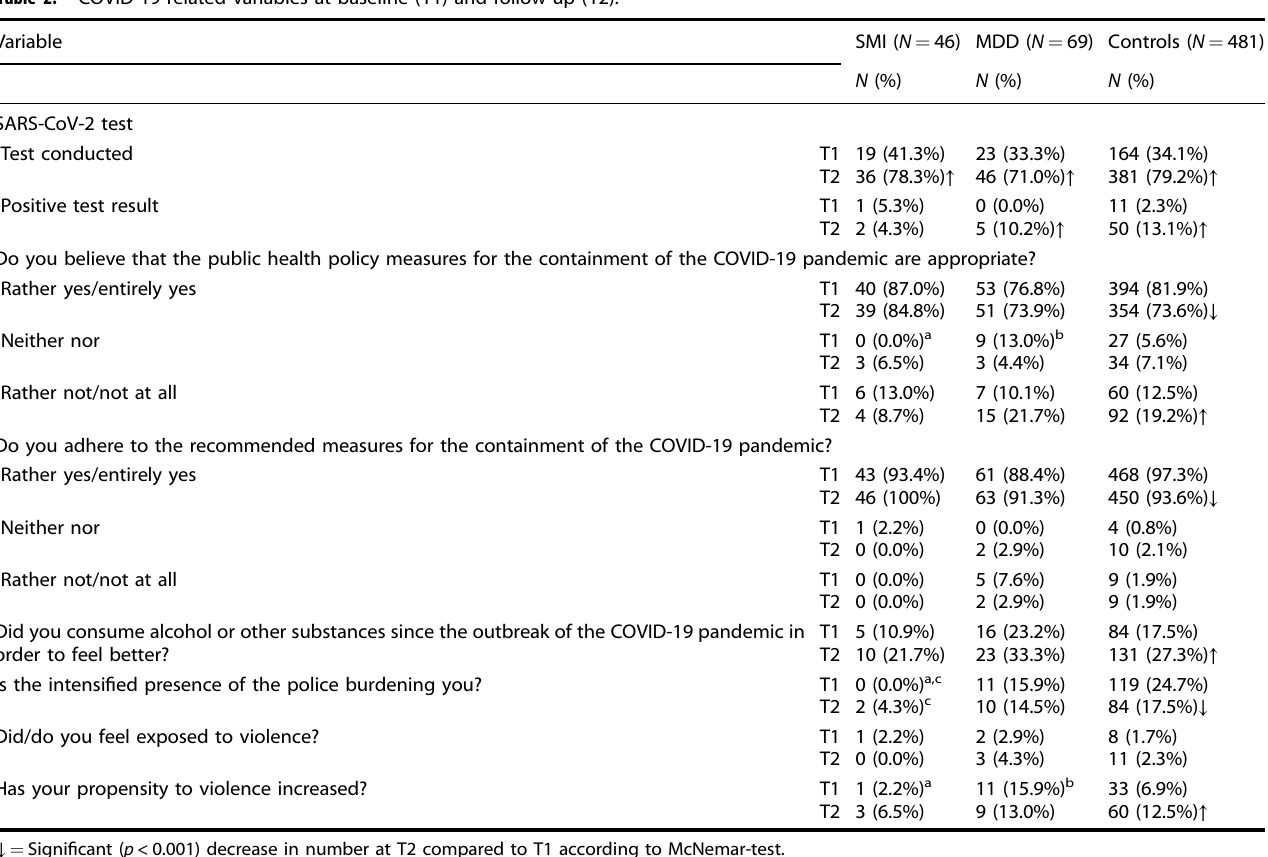
Table 2. COVID-19-related variables at baseline (T1) and follow-up (T2).